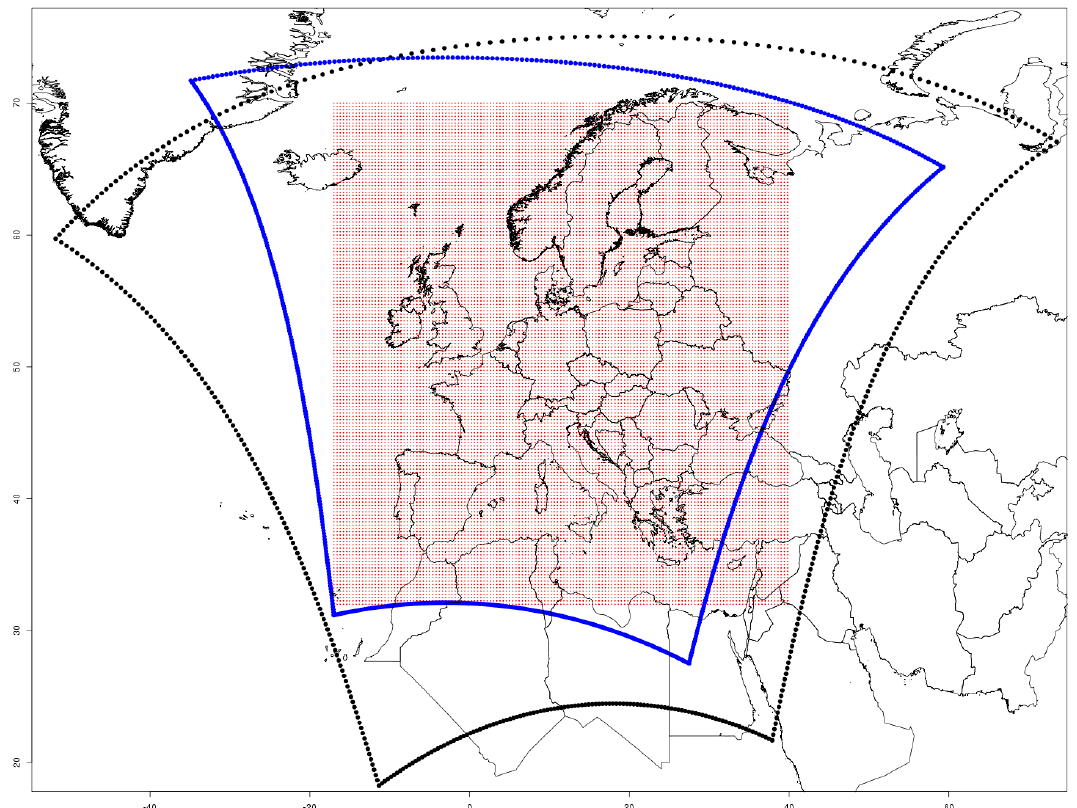
Figure 2. Modelling grid used by all the chemistry transport models involved in EURODELTA-Trends (red dots) with the exception of CMAQB, which could not implement a regular latitude–longitude grid (outer grid cell of the modelling domain displayed with blue dots). The outer grid cells of the meteorological forcing data on the EuroCordex grid are also displayed (black